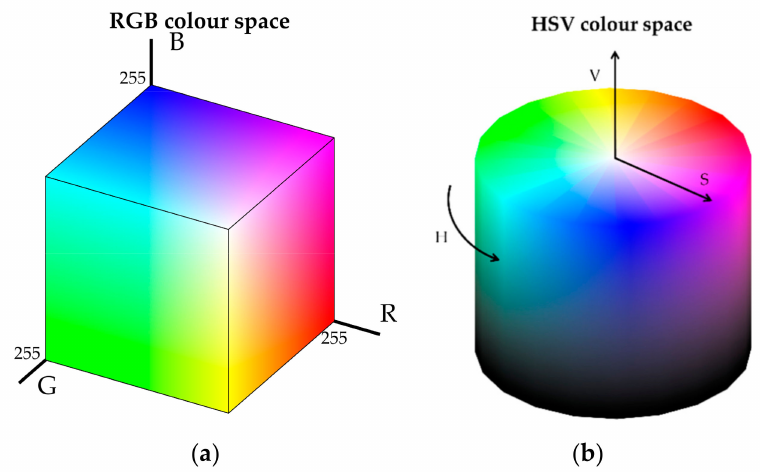
Figure A1. Representation of the ( a ) RGB and ( b ) HSV colour